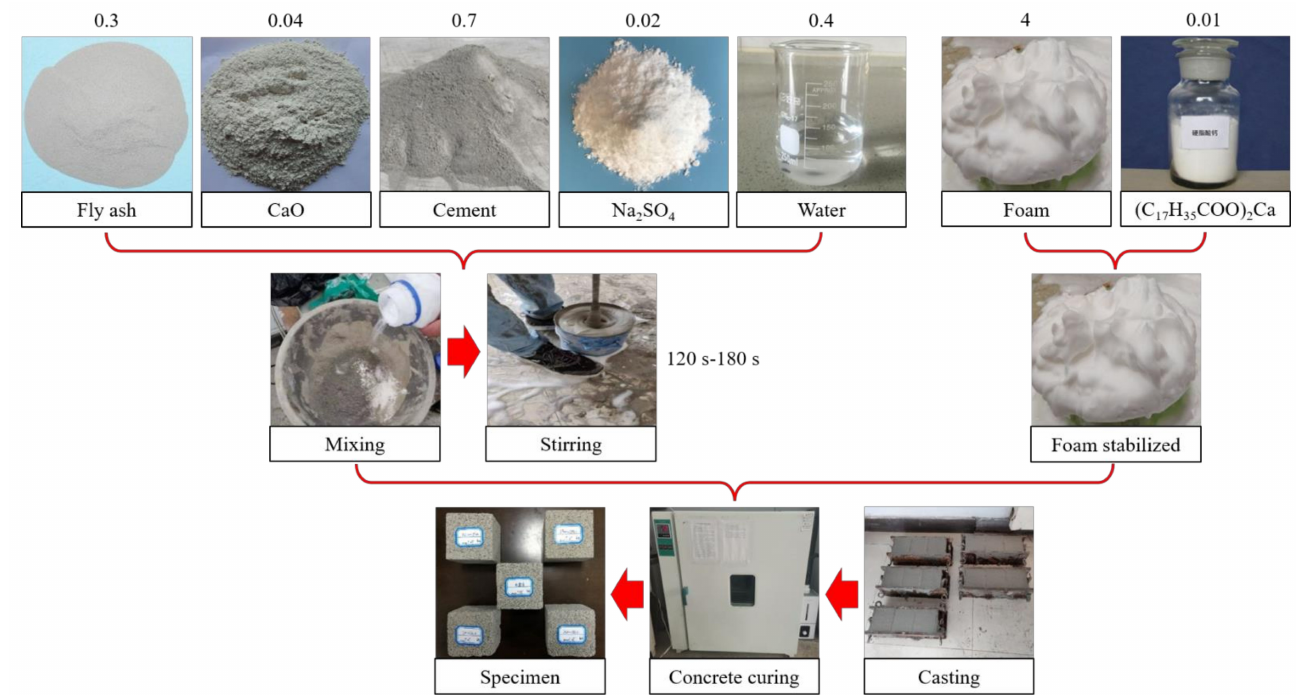
Figure 6. Preparation of fly-ash-based porous geopolymers and the proportioning of raw materials (note: the percentages were obtained from the ratios of masses of corresponding materials to the total mass of cement and fly